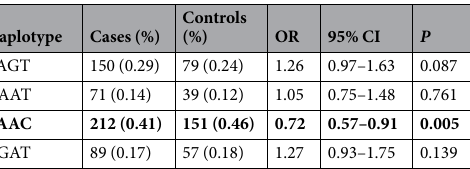
Table 4. Association between SIRT1 tagSNP haplotypes and the risk of ASP. Positive results are in